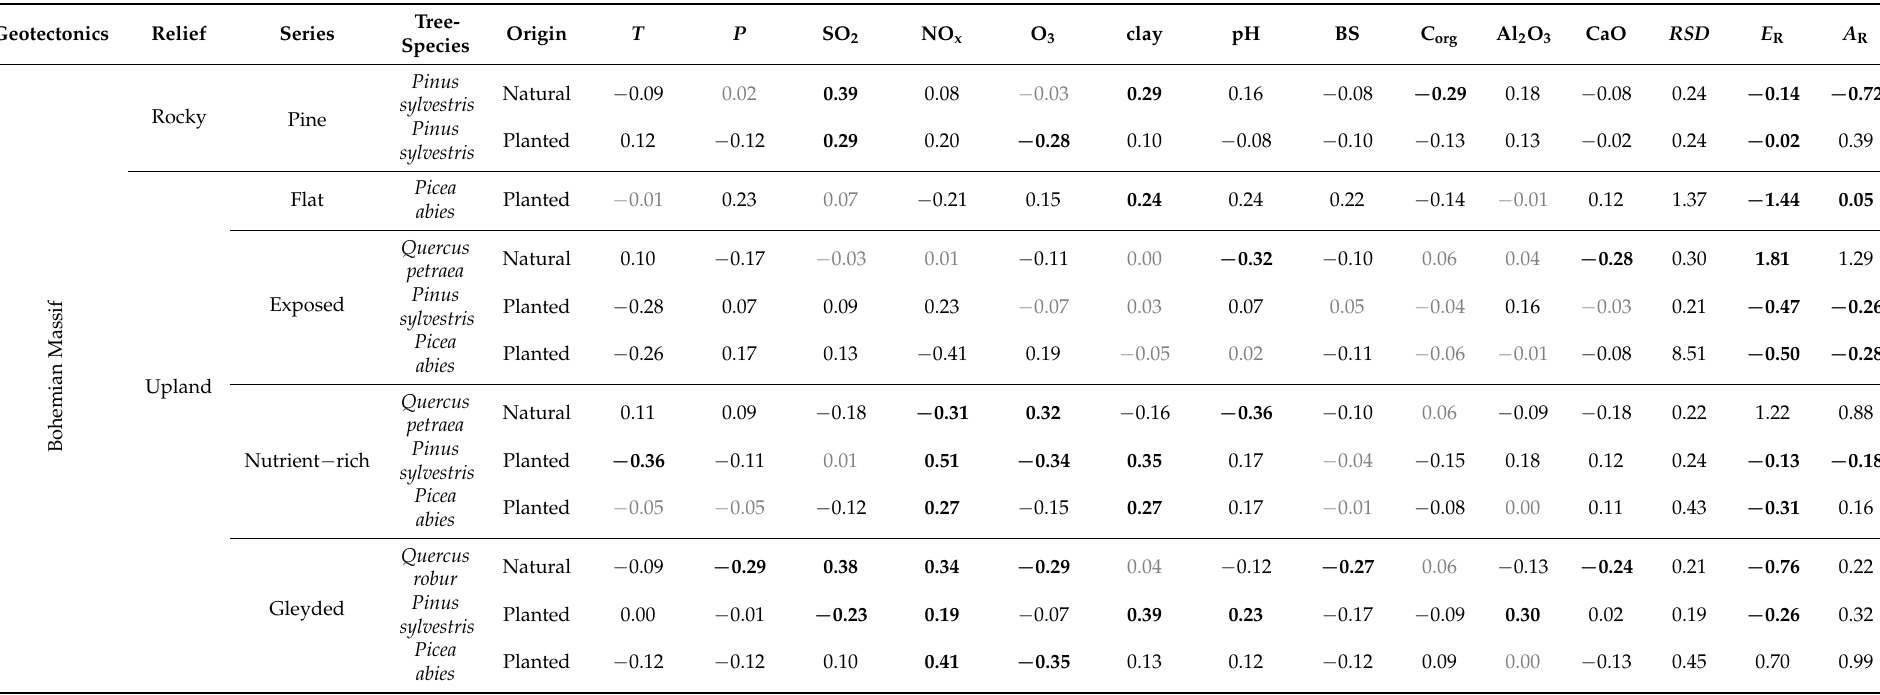
Table 5. Linear correlations and analysis of residues between tree current basal-area increment and properties of growth conditions at sampled forest stand type. Bold statistically significant correlation at p < 0.05, normal less significant between p ≥ 0.05 and p < 0.50 and light insignificant at p ≥ 0.50. RSD —residual standard deviation; E R —residual elevation; A R —residual skewness (for detailed information about properties of growth conditions see Tables 2 and